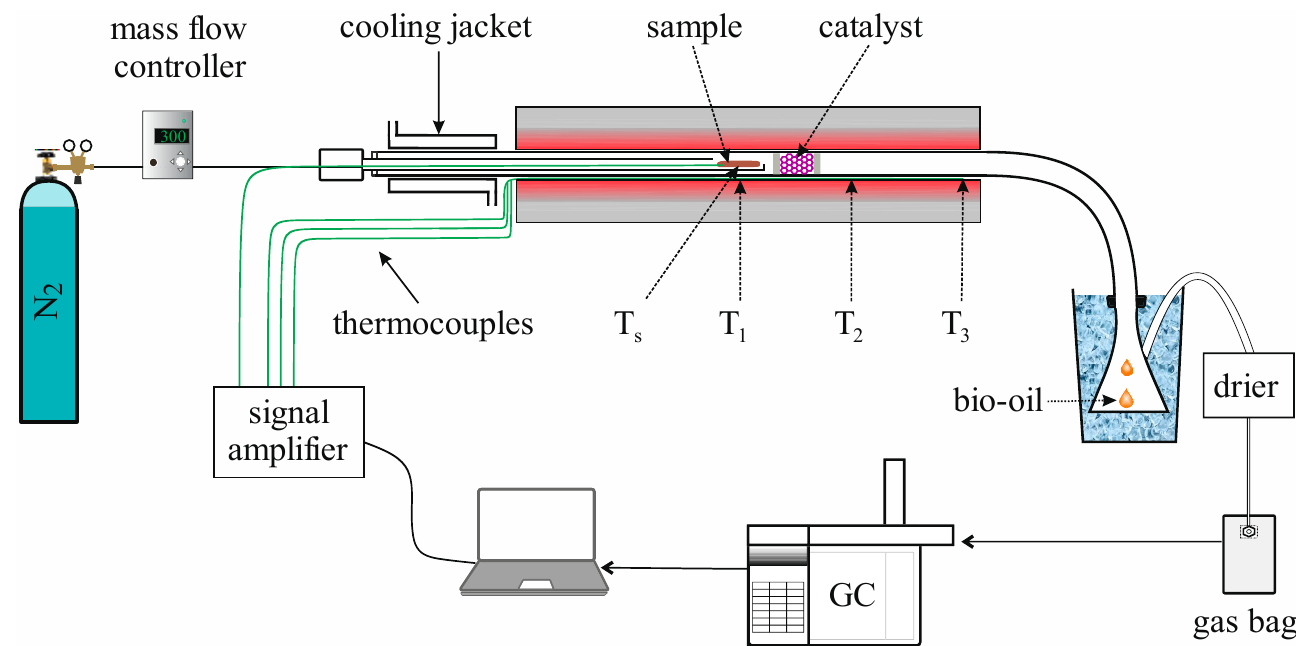
Figure 1. Intermediate pyrolysis system adapted from [10].